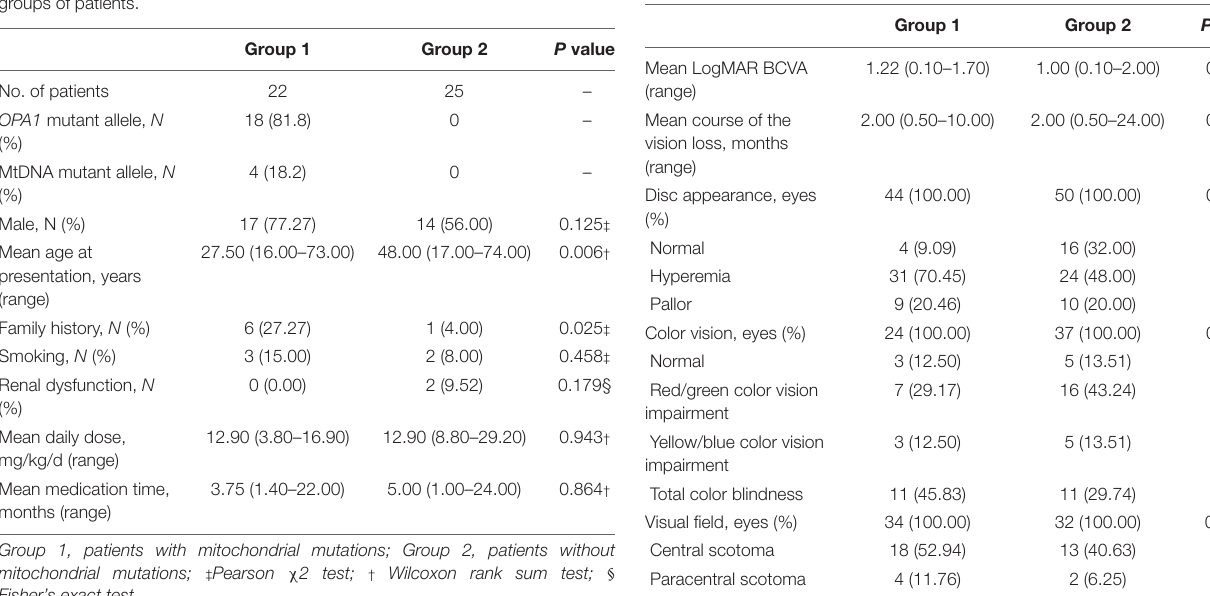
TABLE 3 | Comparison of the clinical characteristic of the two groups of